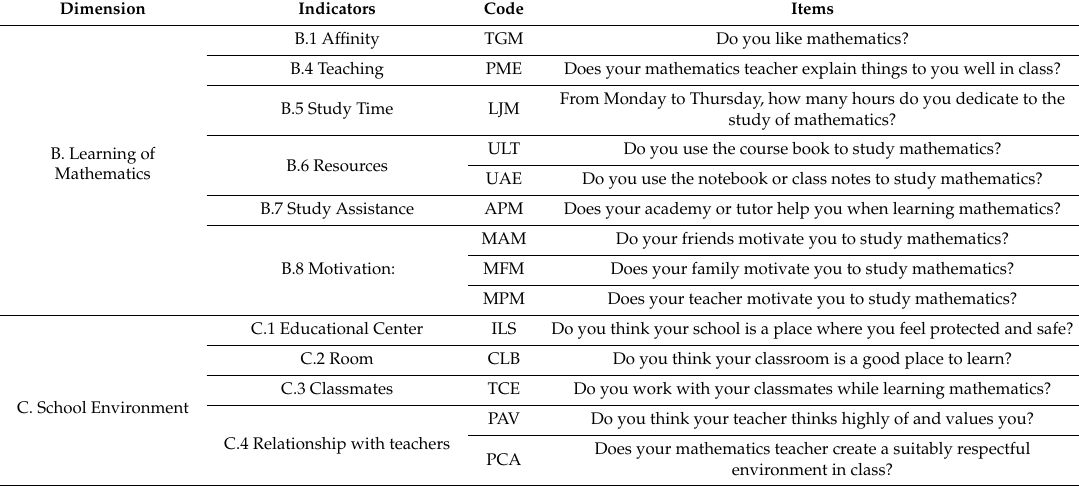
Table 1. Relationship between dimensions, indicators, and items.